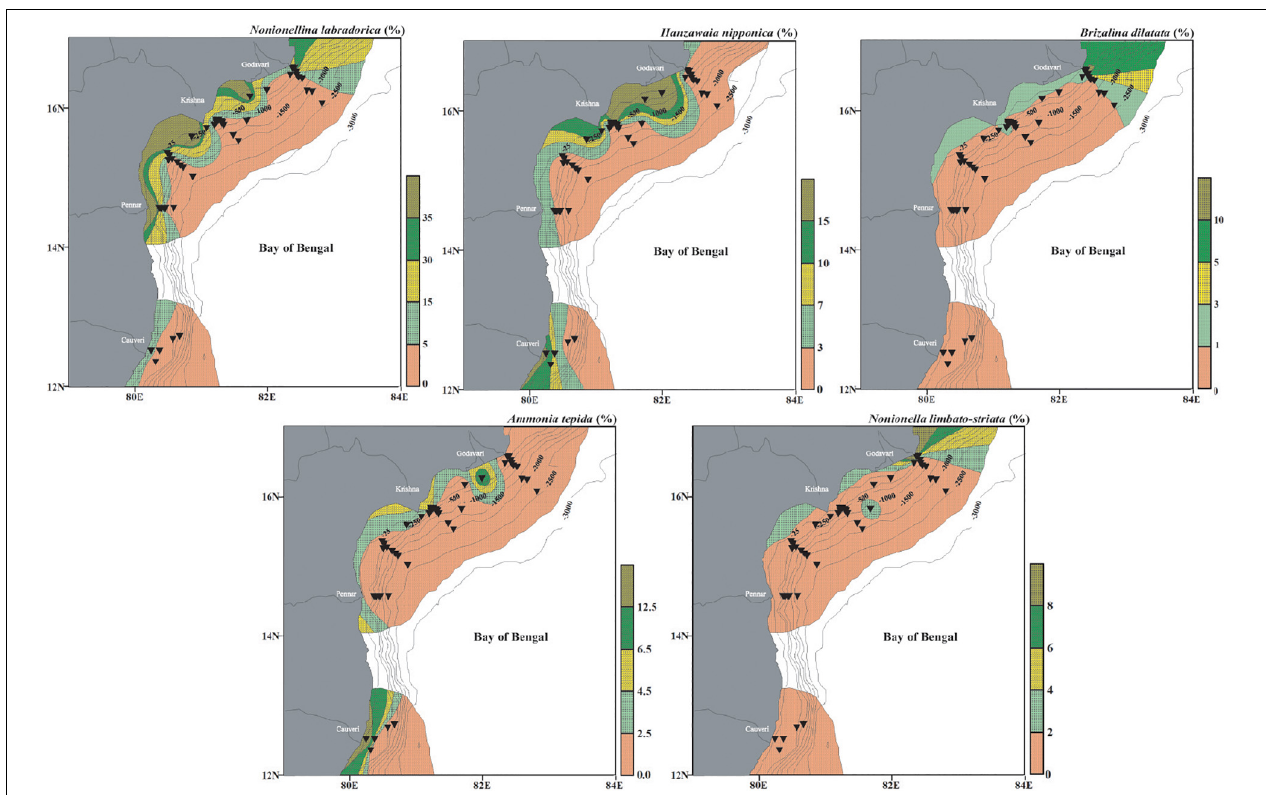
FIGURE 10 | Surface distribution (relative abundance) of dominant living benthic foraminifera from Cluster IV representing Assemblage I and having a significant positive correlation with dissolved oxygen and temperature. Nonionella labradorica , Hanzawaia nipponica, Brizalina dilatata , Ammonia tepida, and Nonionella limbato-striata. The stations are marked by black inverted triangles. The thin black lines mark the bathymetric